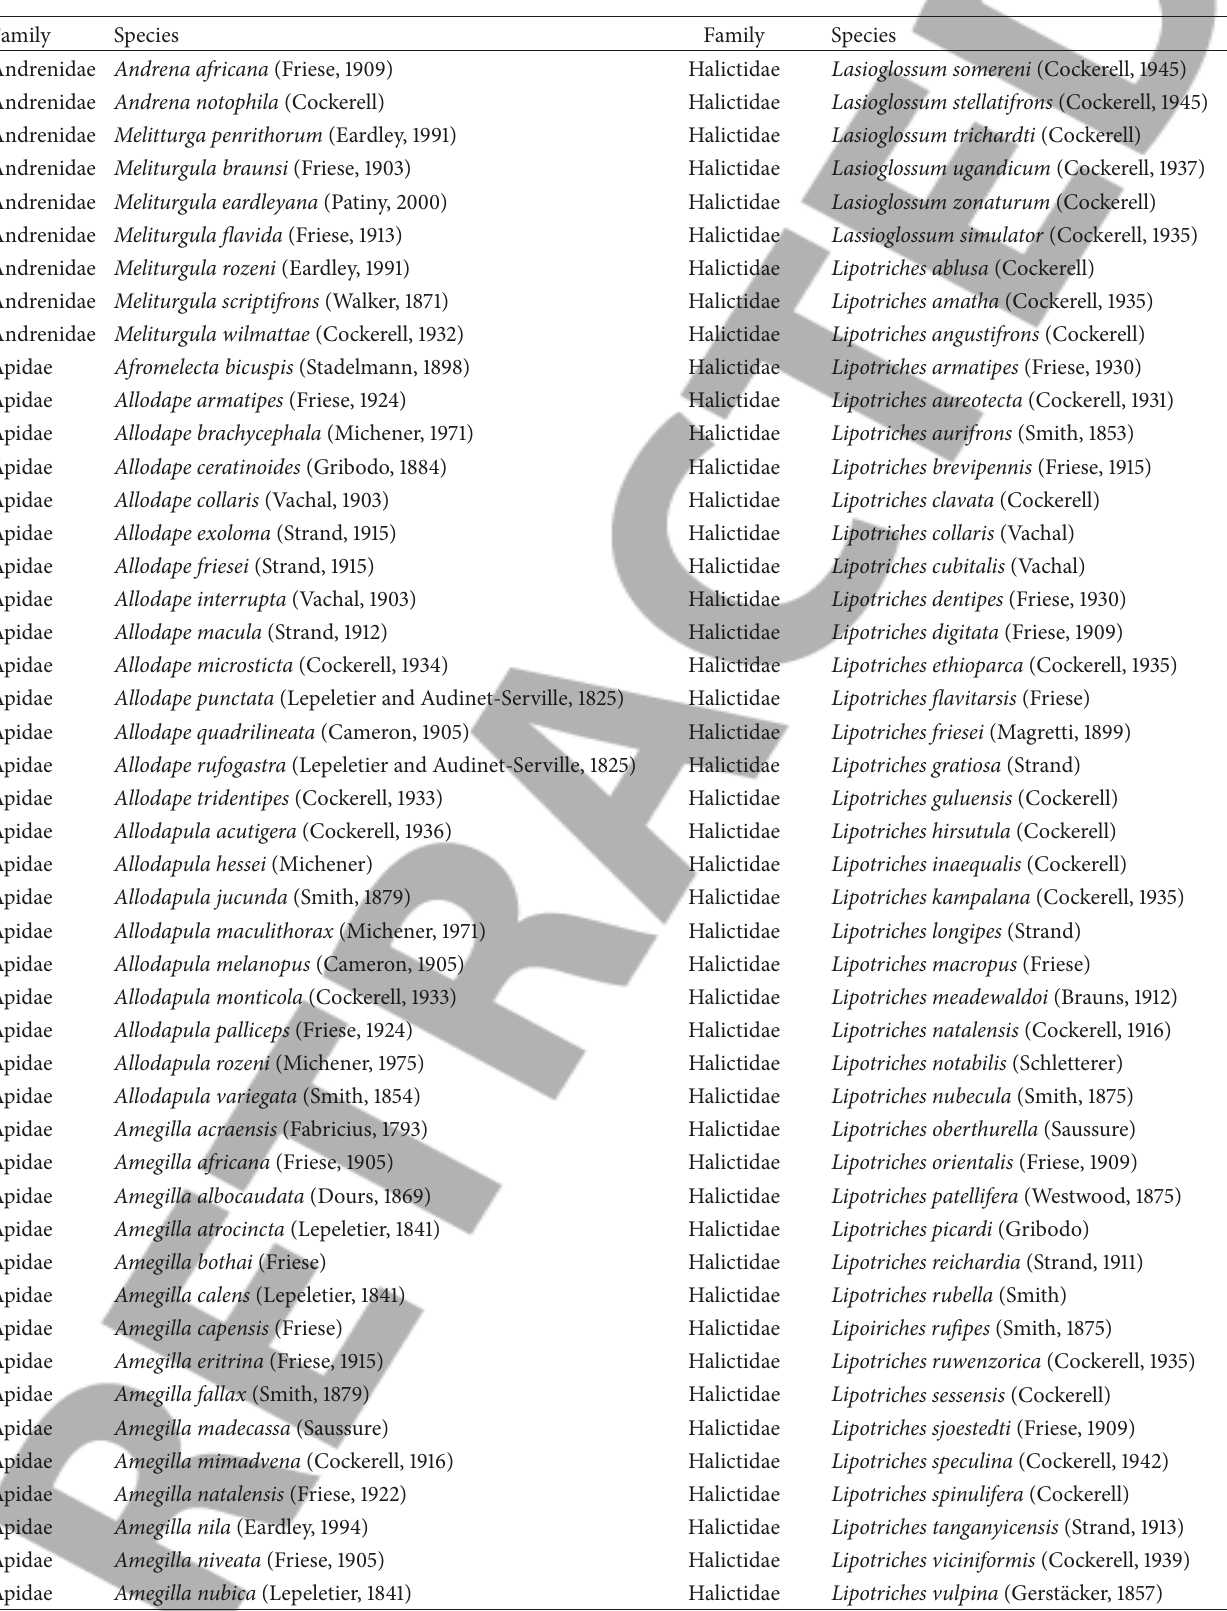
Table 8: List of bee species collected in coffee-banana agroforestry systems in central Uganda in 2006.